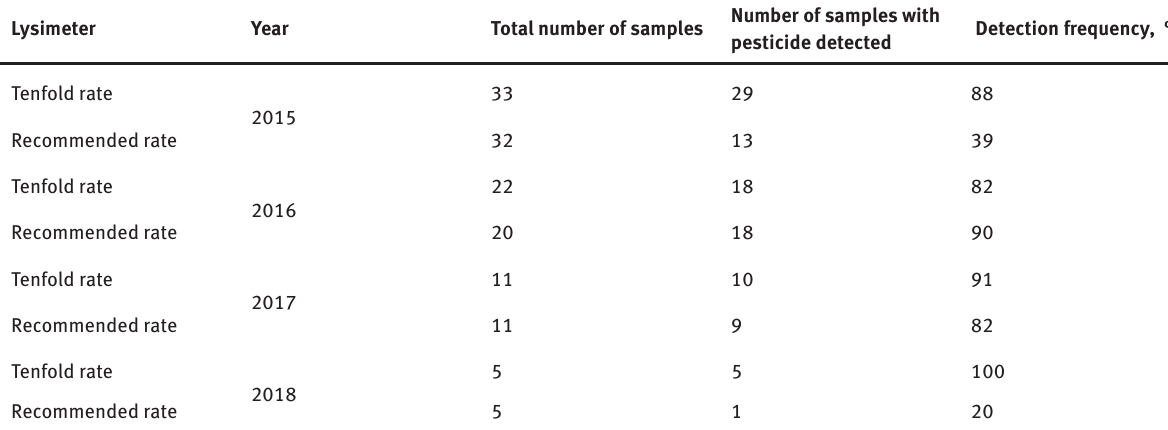
Table 6: Cyantraniliprole concentration in leachate